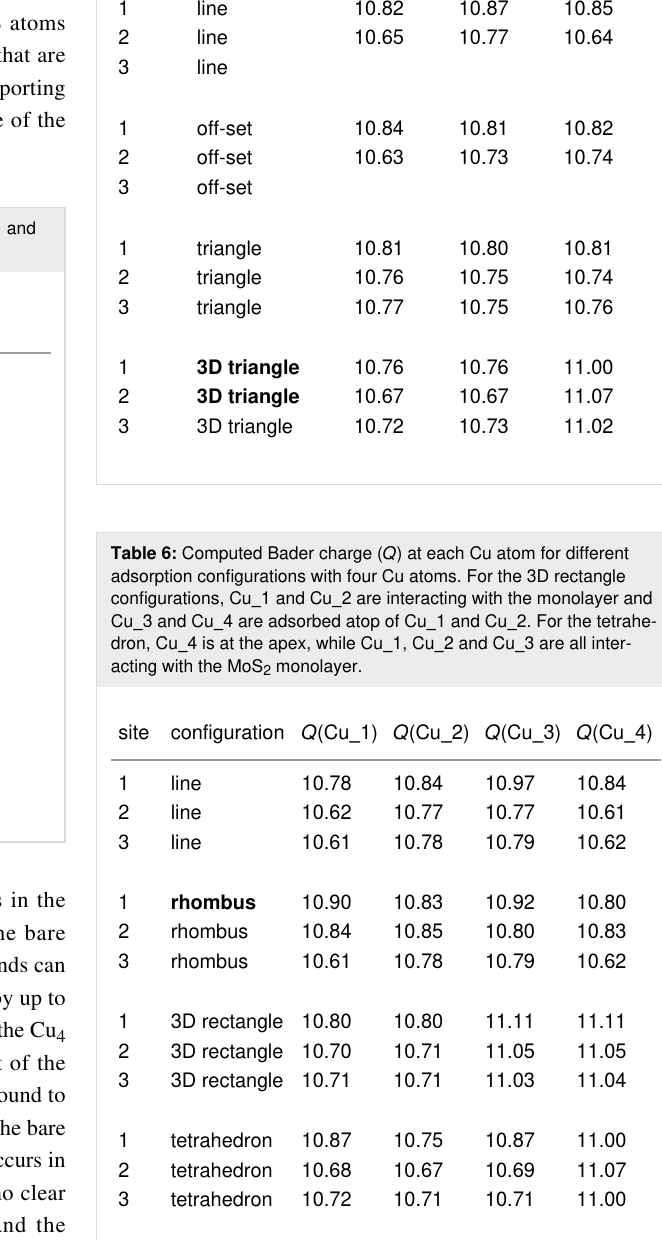
Table 5: Computed Bader charge ( Q ) at each Cu atom for different adsorption configurations of three Cu atoms. In 3D structures, Cu_1 and Cu_2 are interacting with the monolayer, while Cu_3 is at the apex of the triangle. site